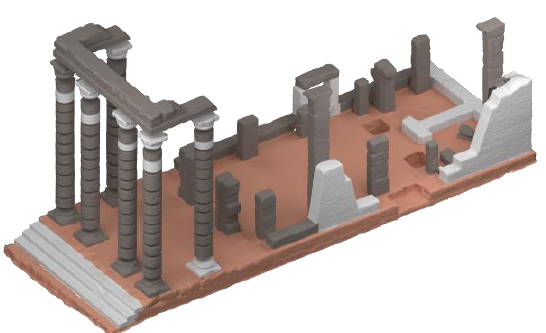
Figure 10. Semantic classification of the temple constructive elements